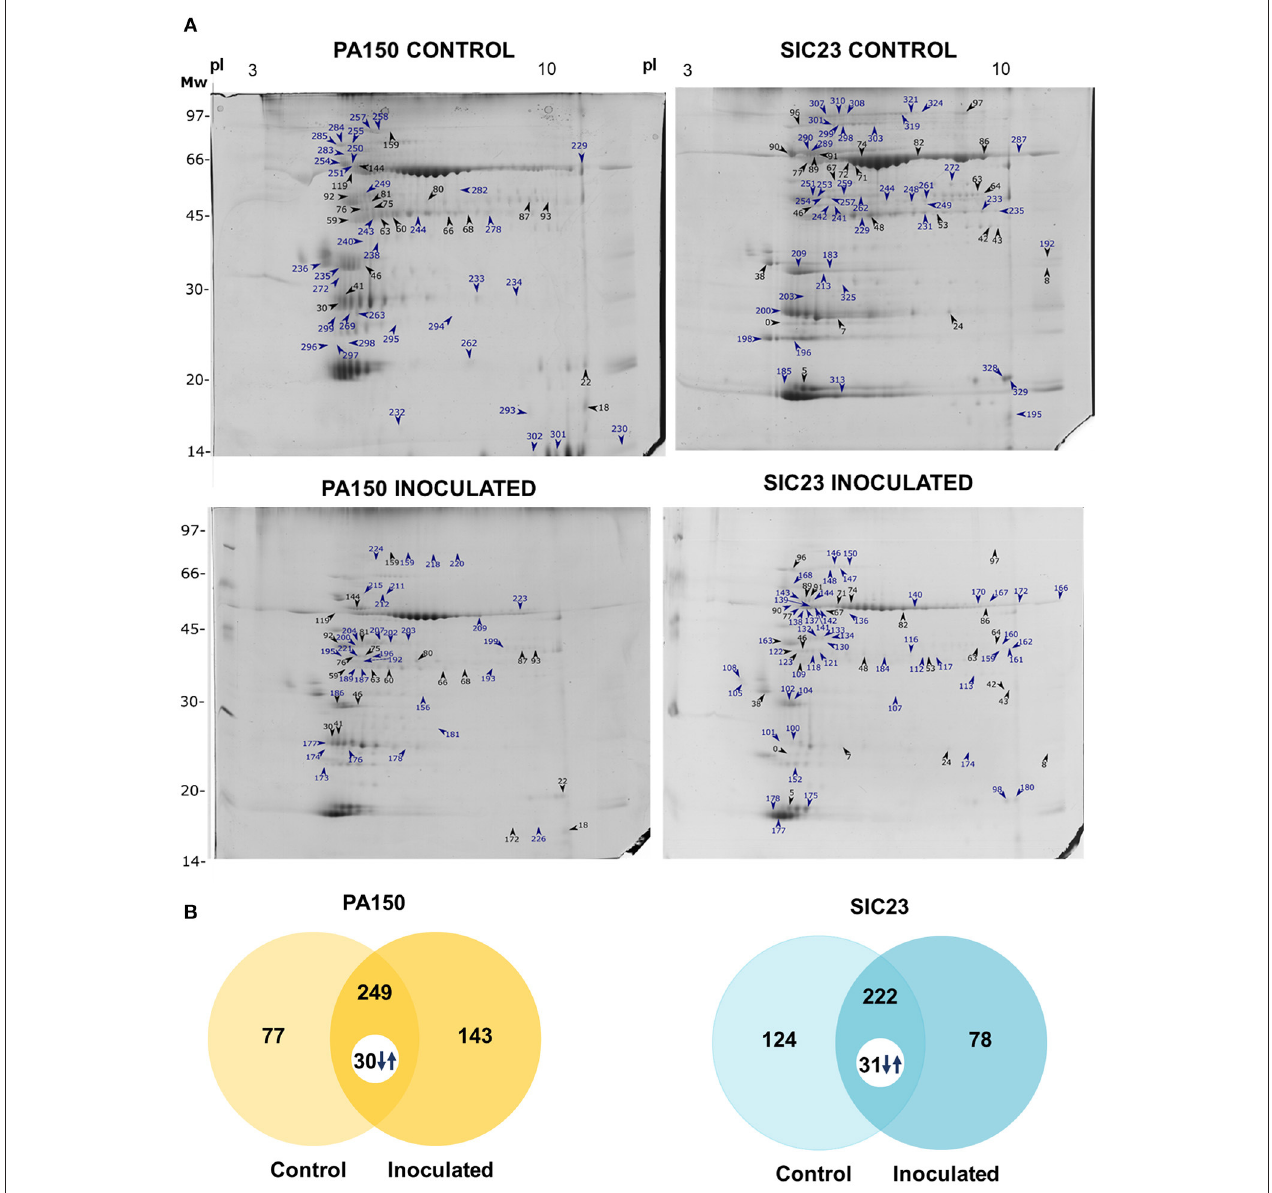
FIGURE 1 | Electrophoretic profiles of cacao leaves inoculated and not inoculated with P. palmivora . (A) SDS-PAGE-2D representative of the inoculated and control treatments of each clone. The spots marked with arrows and numbers are those from which the proteins in Tables 1 , 2 were identified. Blue arrows and numbers indicate the spots detected exclusively in each treatment; black arrows and numbers indicate common spots that are differentially accumulated; (B) Venn diagrams representing the spots detected in resistant (PA 150) and susceptible (SIC 23) clones in the control and inoculated treatments. The numbers accompanied by arrows are the spots common to both treatments that had a significant difference in accumulation considering the ANOVA p < 0.05 and fold > 1.5